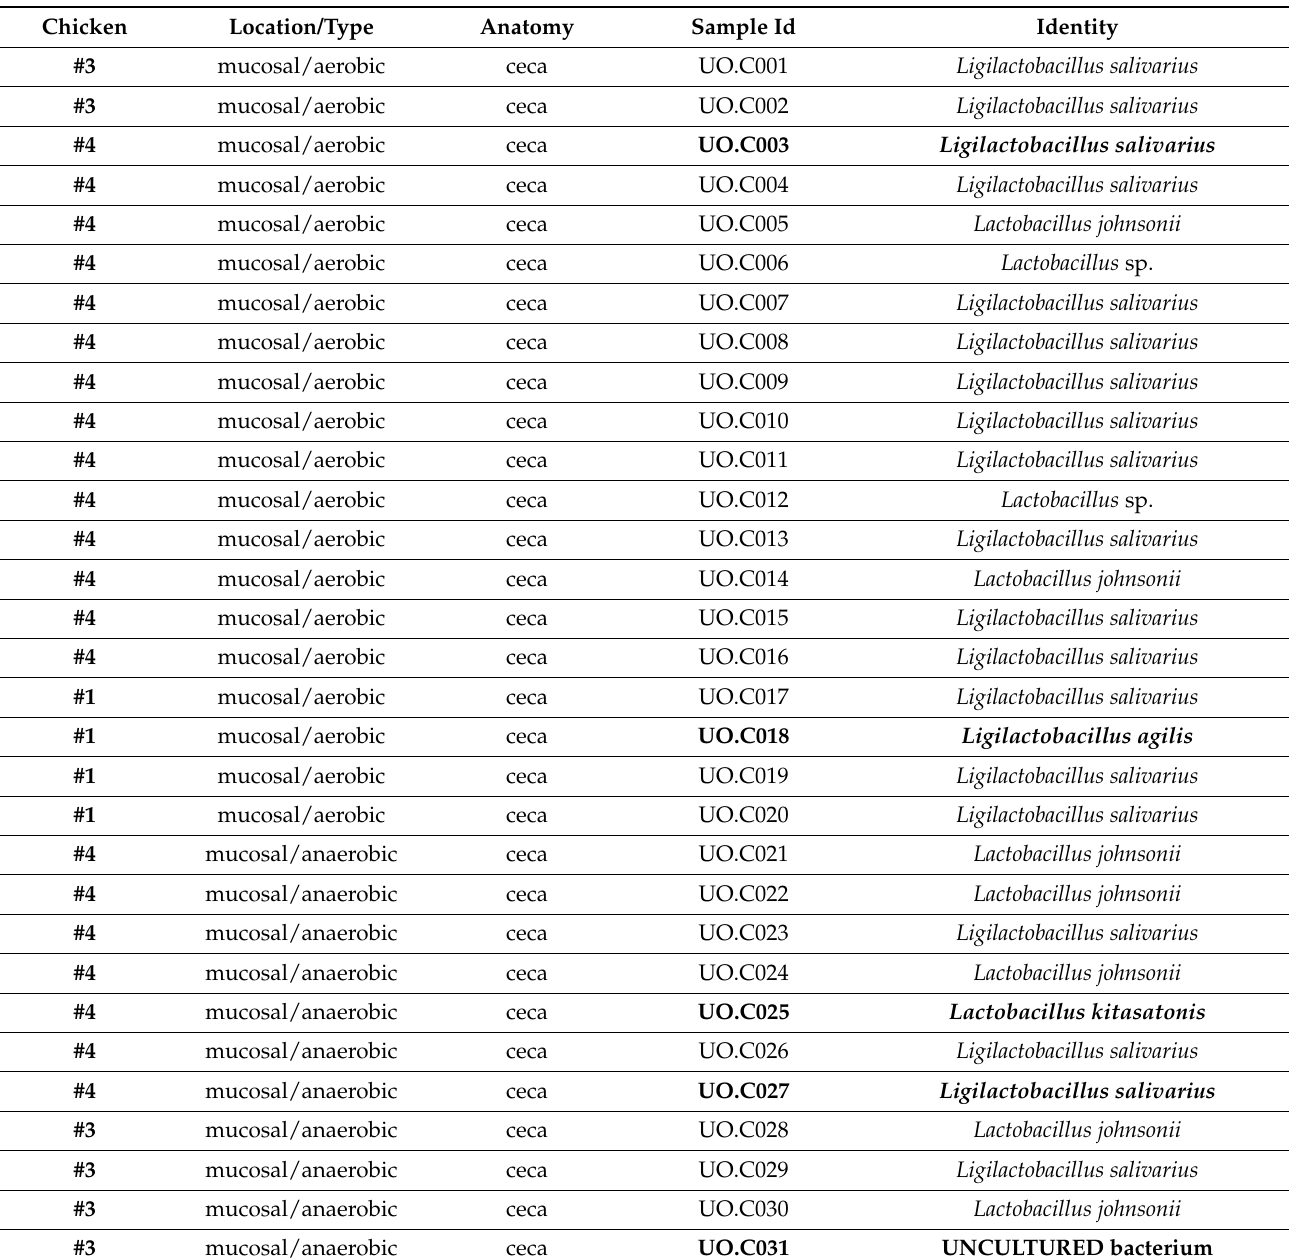
Table 2. Molecular identification of isolated bioactive strains by 16S rRNA sequencing. Strains in bold represent the five most potent strains that were further characterized for their probiotic